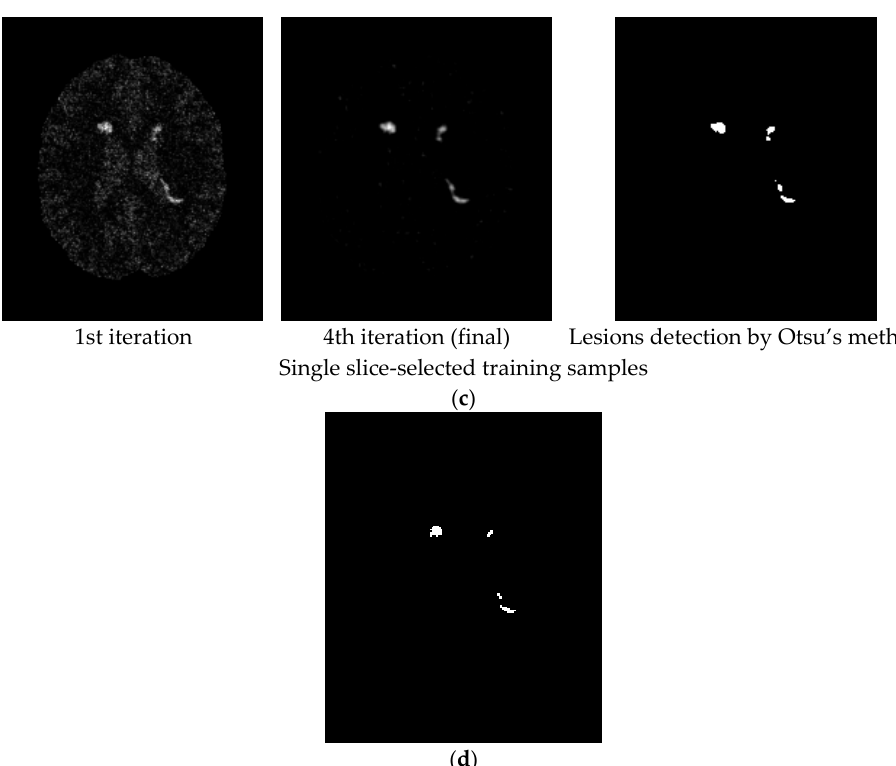
Figure 10. Lesion detection of Slice 97 with 9% noise and 0% INU by CBEP-ICEM1 and CBEP-ICEM2. ( a ) Original 97th slice of MS MR brain images with 9% noise and 0% INU; ( b ) CBEP-ICEM1; ( c ) CBEP-ICEM2; ( d ) Lesion detection LST.